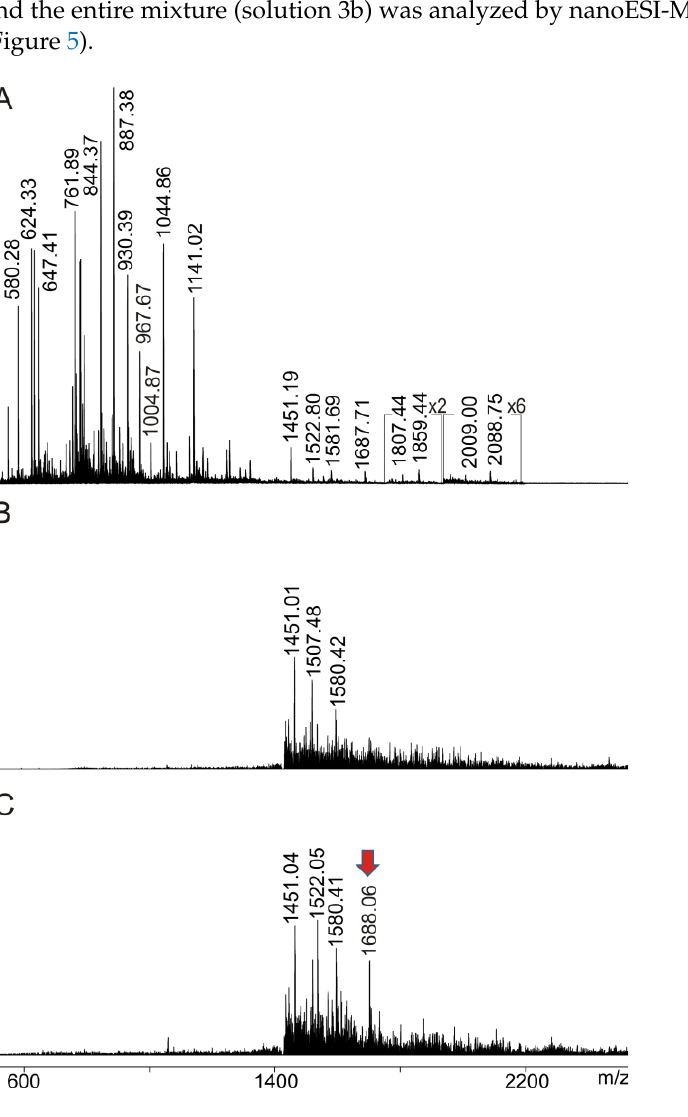
Figure 5. ITEM—SIX analysis. ( A ) NanoESI mass spectrum of ions from Ovalbumin upon